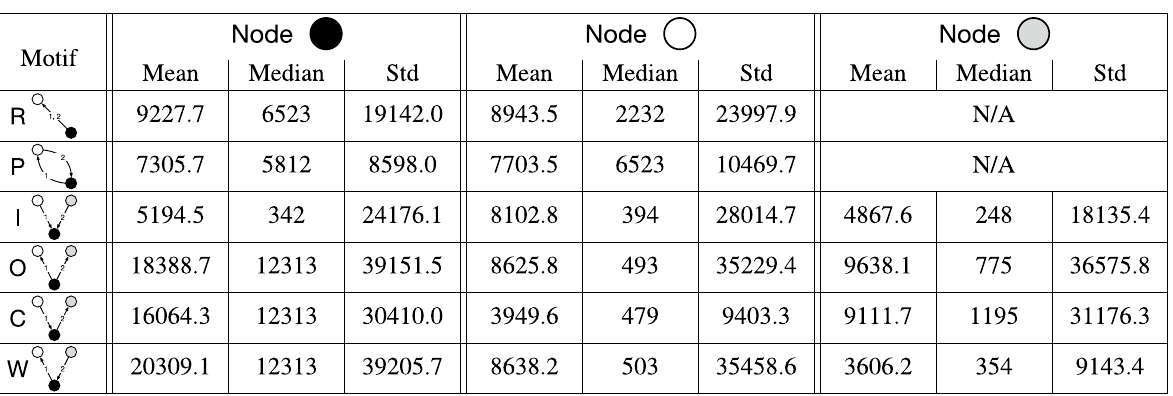
Table 2. Size of the company for each node in the 2-event opposition motifs. We show the mean, median, and standard deviation (denoted by Std in the table) of the number of patents owned by the companies for each node in a given type of motif. For the entire network, the opposer and opposed companies have 4119.9 and 6492.8 patents on average,